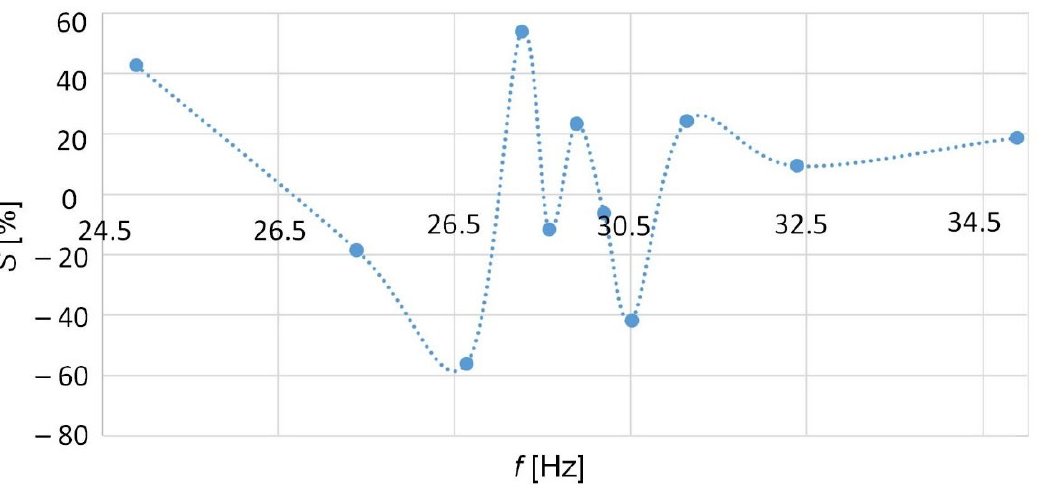
Figure 10. Dependence of the response rate parameter of a biological system on the change in frequency, sample C.